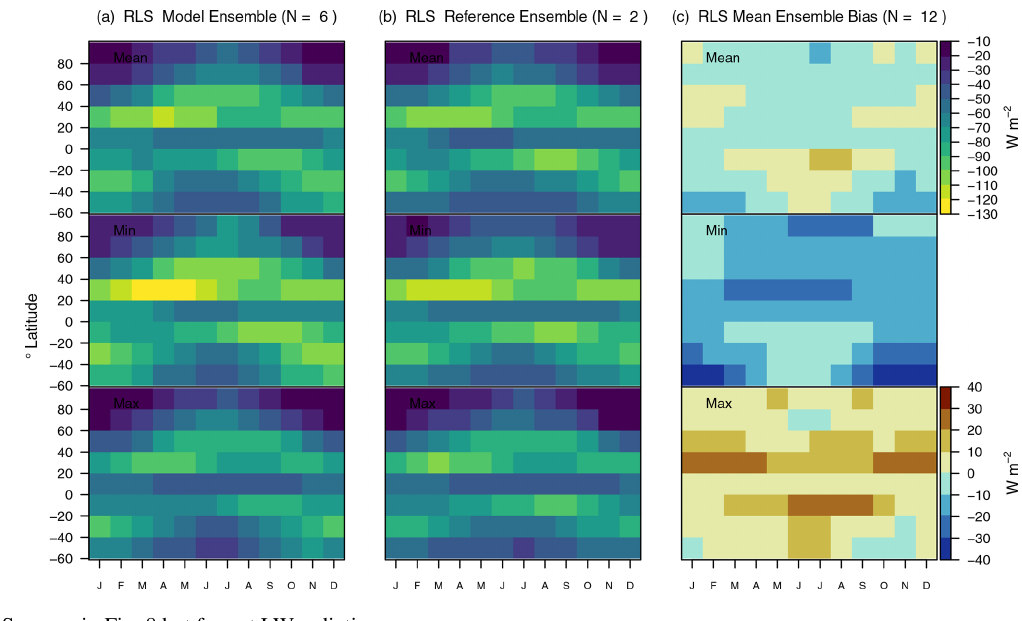
Figure A5. Same as in Fig. 8 but for net LW radiation.